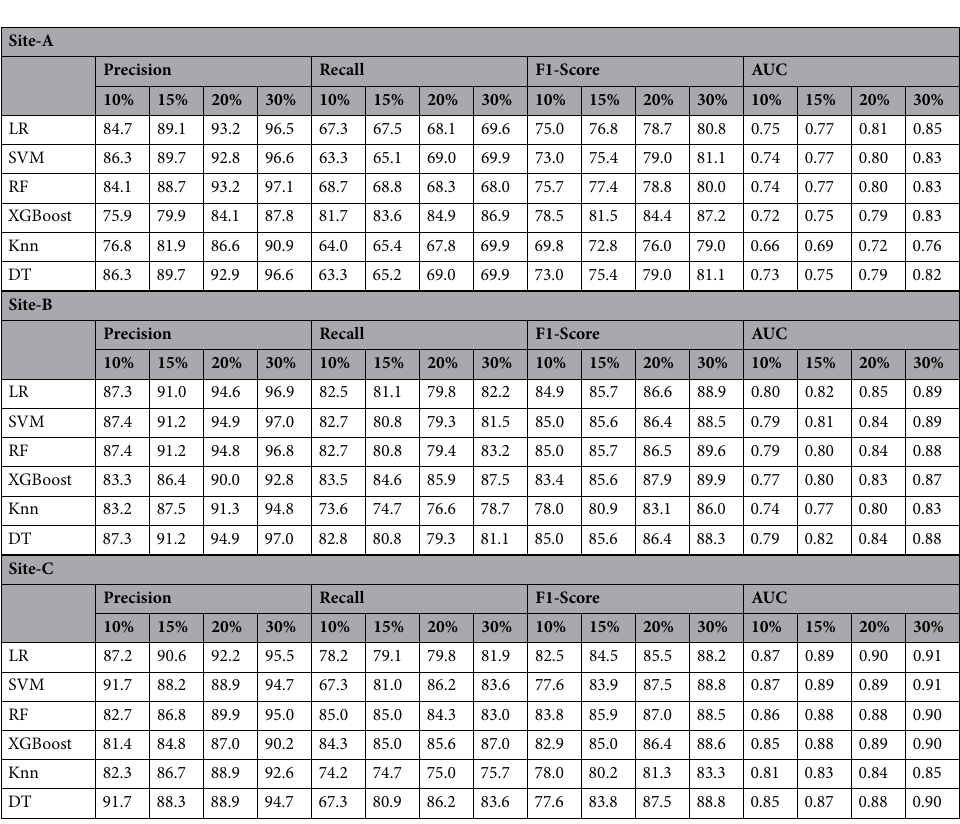
instances of a large increase in EF values. Across all sites, XGBoost showed the highest performance in terms of F1-score and AUC. It should be noted that, while other models performed comparably to XGBoost in Site-B and Site-C, the performance of these models was lower in Site-A. Similarly, Table 4 shows prediction performance of various models in classifying patients with a decrease in EF in 10, 15, 20, and 30 percentages from the baseline values versus those patients with either increased or stable EF from their baseline values. Across all sites, except for XGBoost, all other models showed high precision, but low recall resulting in a moderate F1-score. The XGBoost model, on the other hand, showed high precision and recall resulting in a high F1-score across all sites. As in the case of EF increase, prediction performance in terms of recall and precision increases when testing for EF decreases from 10 to 30%. The highest performance observed for 30% EF decrease for all models. However, unlike the EF increase case, the AUC values were generally low with no significant change for the various cases of EF decrease, implying low confidence in models prediction ability. The low AUC is further evidenced from the feature importance analysis shown below. For all EF decrease cases, Site-C showed higher AUC values than the corresponding values in Site-A and Site-B.